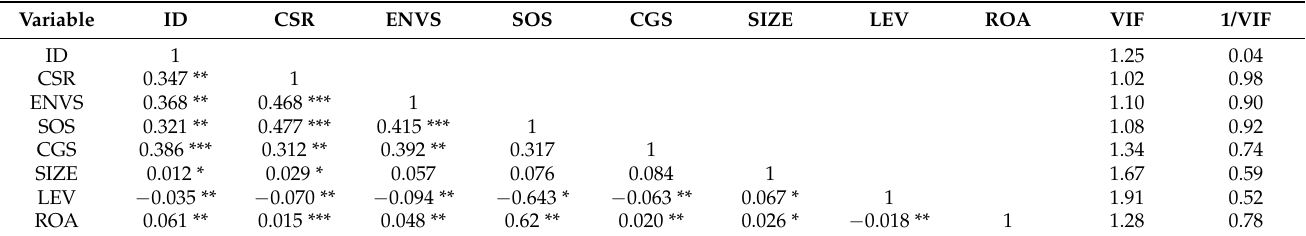
Table 2. Pearson correlation matrix and variance inflation factor